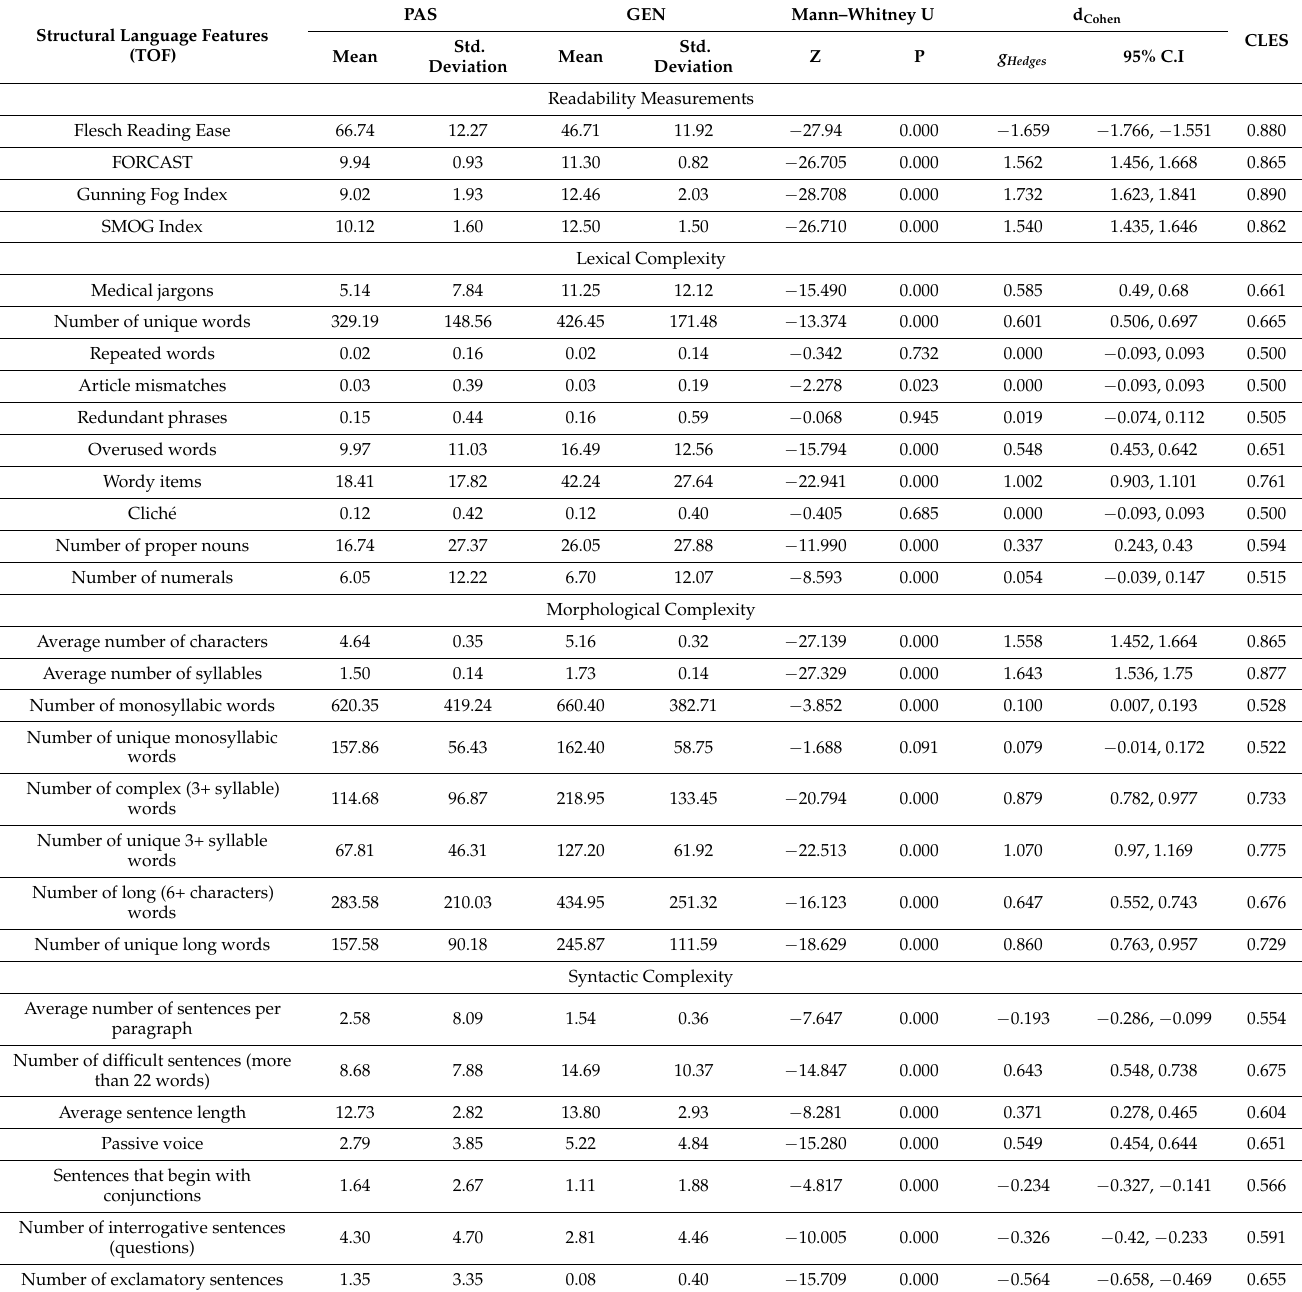
Table 1. Mann–Whitney U test, Effect Sizes ( d CoheN ) and Common language effect sizes (CLES) of structural features